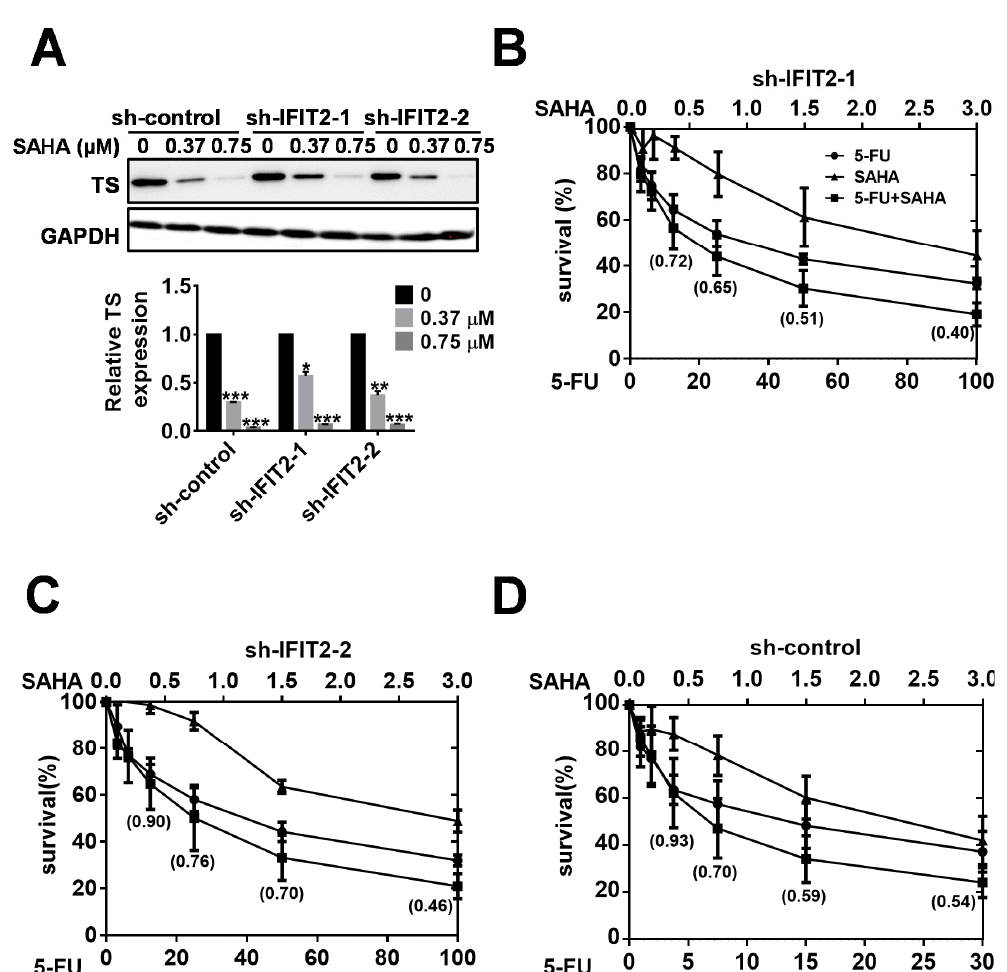
the optimal ratio of 5-FU and SAHA as 33:1 for the synergistic e ff ect in sh-IFIT-1 and sh-IFIT-2 cells (Figure 6B,C), while 10:1 in sh-control cells (Figure 6D). Combination index (CI) values portrayed the synergism of SAHA and 5-FU at a ratio of 33:1.